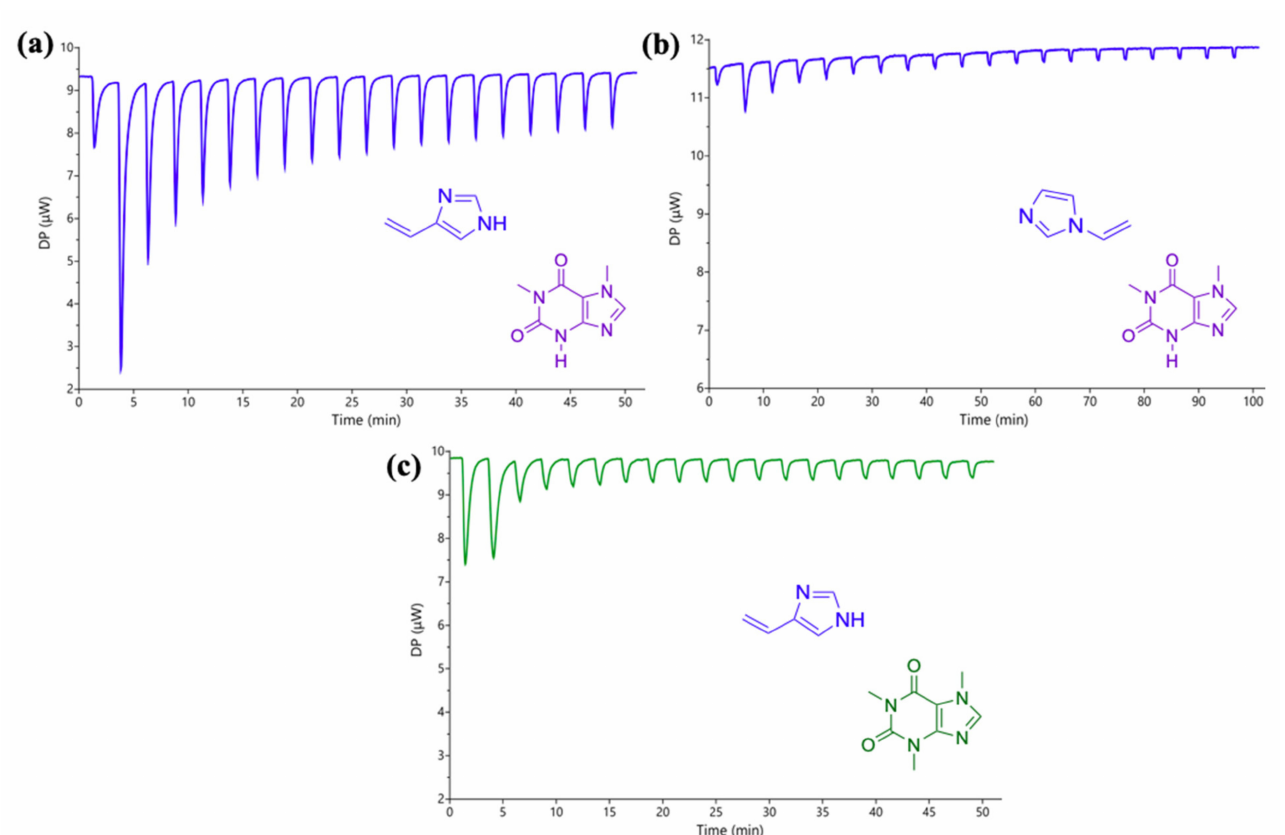
Figure 7. Raw ITC data for the stepwise injection of ( a ) 4-vinylimidazole (4VI; 10 mM) into a solution of paraxanthine (PX; 2 mM); ( b ) 1-vinylimidazole (1VI; 10 mM) into a solution of PX (2 mM) and ( c ) 4VI (10 mM) into a solution of caffeine (2 mM). All solutions were prepared in water and the titrations were carried out at 25 ◦ C.